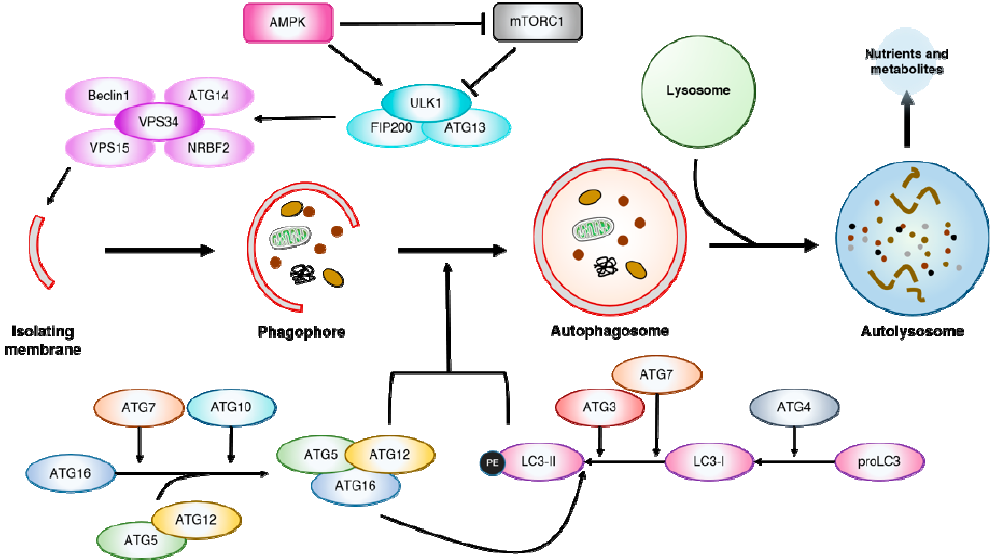
Figure 1. The autophagic process. The autophagic machinery starts with the formation of an isolation membrane, forming the double-membraned intermediate, the phagophore. The maturation of the phagophore into an autophagosome is dependent on the activity of two ubiquitin-like conjugation systems, the LC3-PE and Atg5-Atg12. In the first system, pro-microtubule-associated protein light chain 3 (proLC3) is cleaved by the cysteine protease Atg4 into LC3-I. LC3-I is then further processed into LC3-II and conjugated with phosphatidylethanolamine (PE) by Atg7 and Atg3, which are E1- and E2-homologous enzymes, respectively. LC3-II associates with the autophagic membranes with the aid of the Atg5-Atg12-Atg16 complex, facilitating phagophore maturation into an autophagosome. The Atg5-Atg12-Atg16 complex is formed by the action of Atg7 and Atg10, E1 and E2 enzymes respectively. This newly formed autophagosome then fuses with a lysosome forming an autolysosome. Here, lysosomal enzymes are responsible for the degradation of the autophagosome and its contents. Once degraded, the macromolecules (nutrients and metabolites) are secreted back into the cytosol. The shapes inside the phagophore and autophagosome are intra-cellular cargo such as (dysfunctional) mitochondria, (aggregated) proteins, etc. targeted for degradation; Atg = Autophagy related proteins.